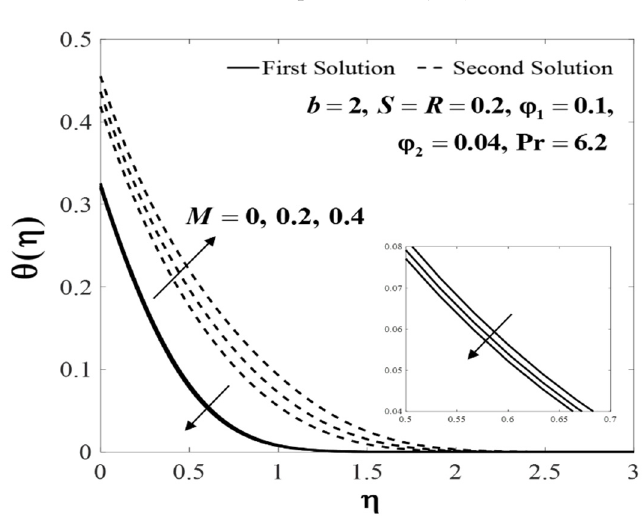
Figure 13. Impact of M on θ ( η ) .